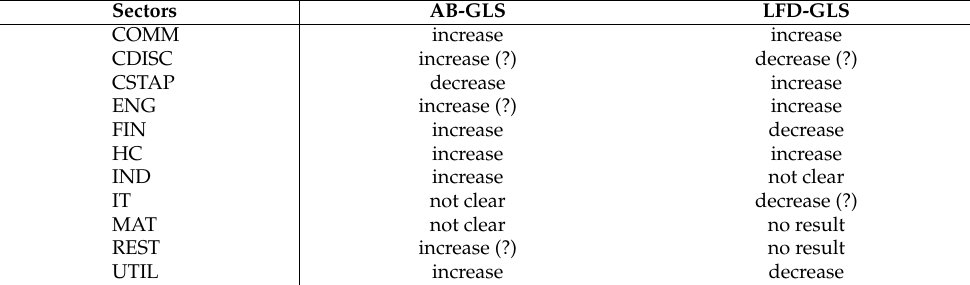
Table 10. Comparing results with the AB-GLS and LFD-GLS models. Sectors AB-GLS increase increase CDISC increase (?) increase (?) increase FIN increase decrease HC increase increase IND increase not clear IT not clear decrease (?) MAT not clear no result REST increase